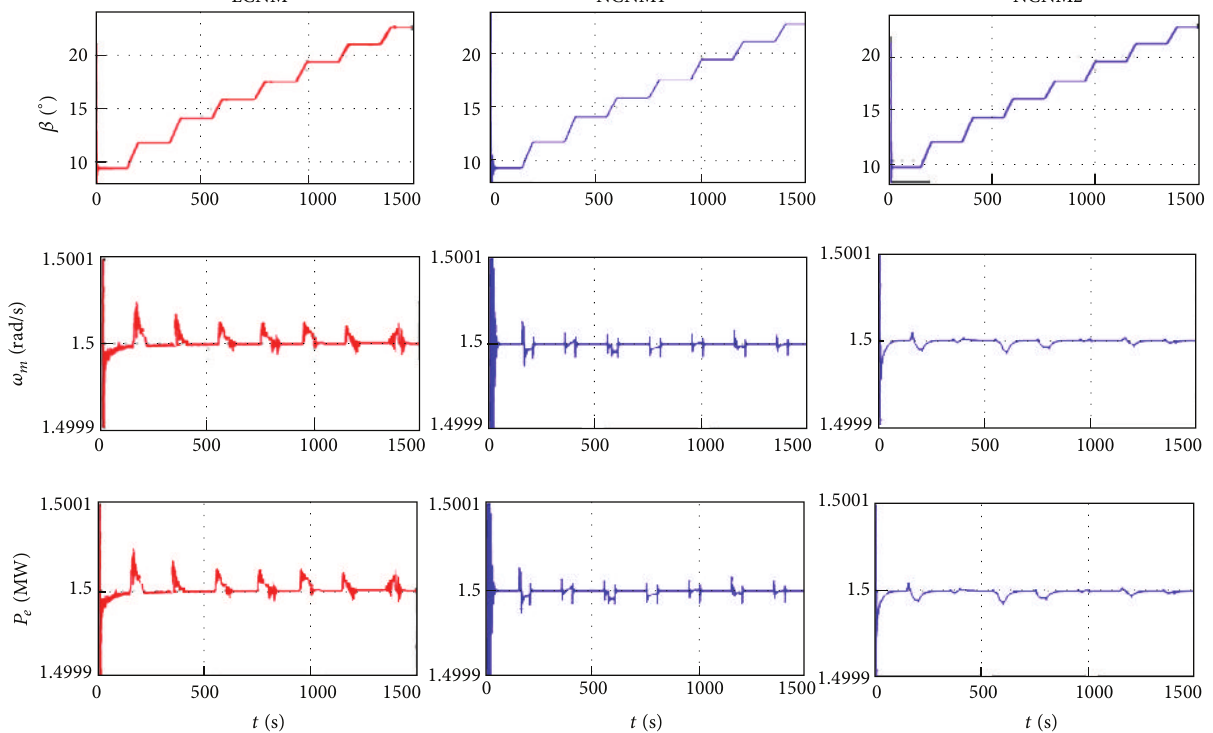
compared with the NCNM strategies because the PI gains are switched based on the detected wind speed. The ANN controller achieves the most accurate control of the turbine speed and output power as the neural network can track the system dynamic online even when the parameter is changing. However, smaller tracking errors would cost more frequent pitch action, which may increase the mechanical fatigue of the